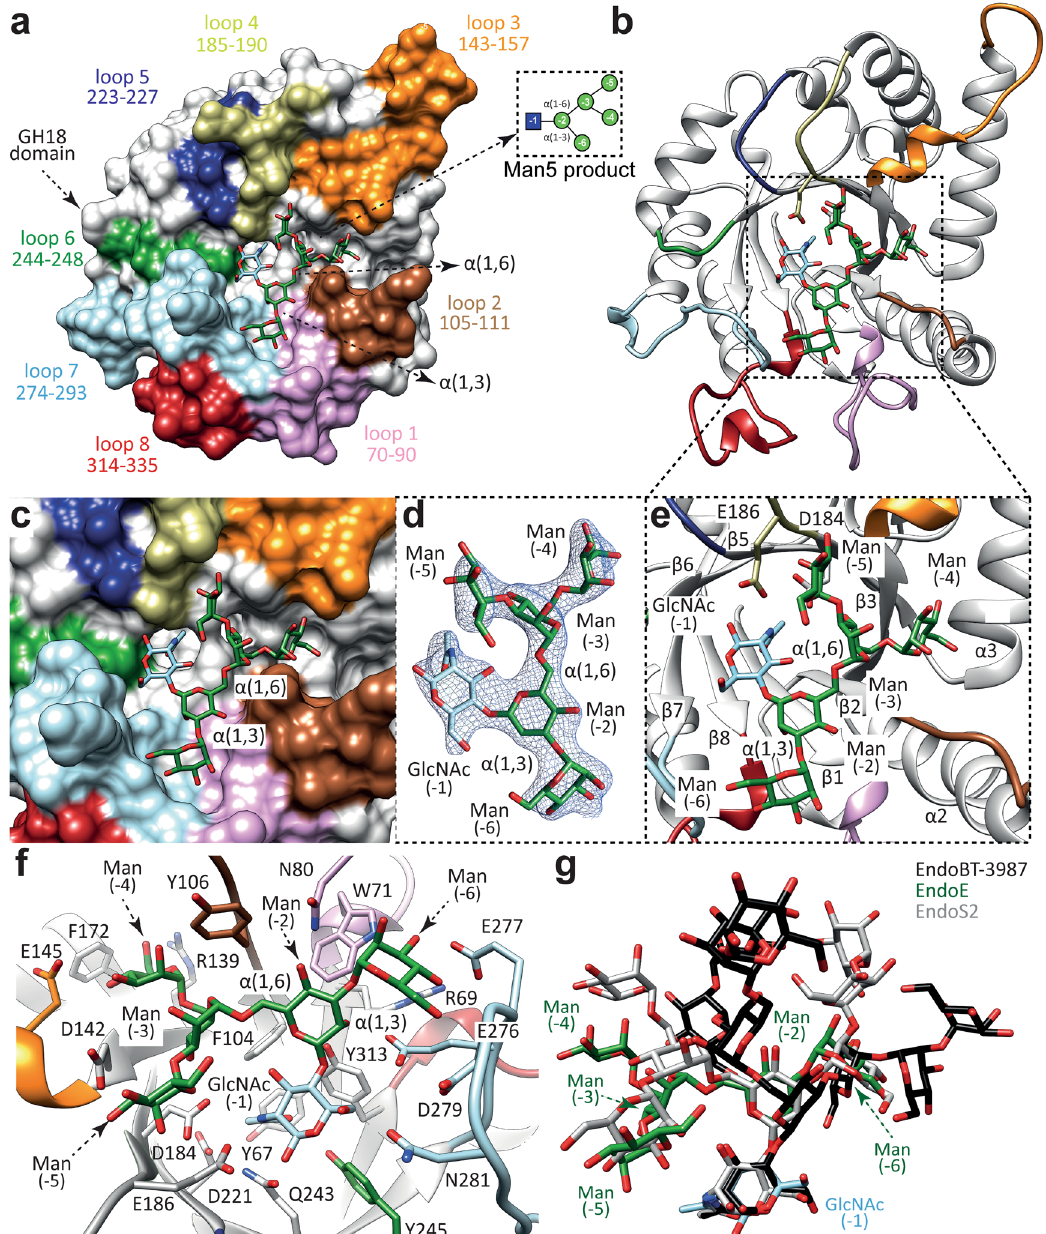
Fig. 8 Structural basis of EndoE GH18 domain substrate speci fi city. a Surface representation of the EndoE-GH18L-Man 5 crystal structure, with annotated domains and loops. b Cartoon representation of the EndoE-GH18L-Man 5 crystal structure. c Surface representation of the GH18 domain of EndoE showing the location of the Man 5 product into the active site. d Electron density map of the Man 5 product shown at 1.0 σ r.m.s.d. e Cartoon representation of the GH18 domain of EndoE showing the location of the Man 5 product into the active site. f Cartoon representation of the GH18 domain of EndoE showing the main residues and secondary structure elements interacting with the Man5 product in the active site. g Superposition of the HM-type N -glycan found in the X-ray crystal structures of EndoE-GH18L (green), EndoBT-3987 (black), and EndoS2